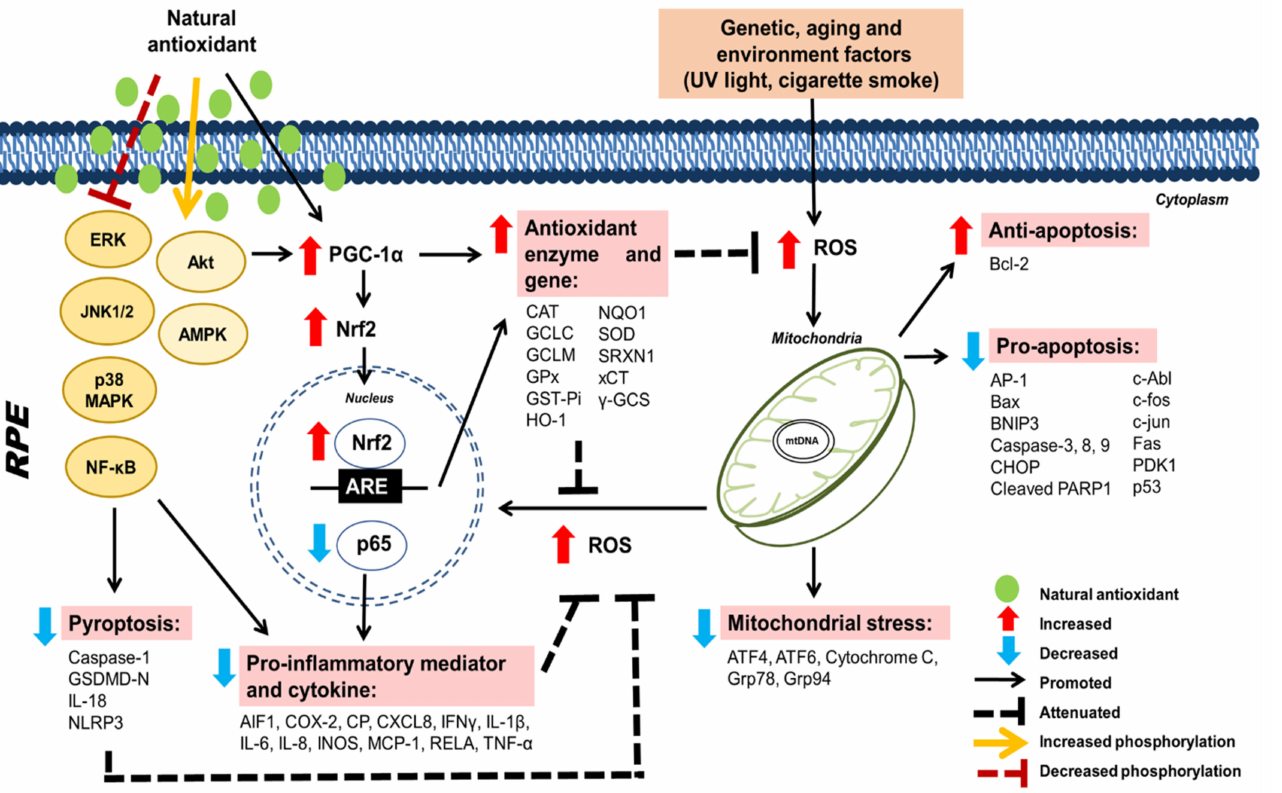
Figure 3. Genetic, aging and environmental factors exaggerate dysfunction and degeneration of reti- nal pigment epithelium (RPE) in age-related macular degeneration (AMD). Excessive production of reactive oxygen species (ROS) leads to mitochondrial dysfunction and mitochondrial DNA (mtDNA) damage, and therefore causing extracellular accumulation of insoluble protein aggregates. Modulation of extracellular-signal-regulated kinase (ERK), c-Jun N-terminal kinase (JNK)1/2, p38 mitogen-activated protein kinase (MAPK), nuclear factor kappa-light-chain-enhancer of activated B cells (NF- κ B), protein kinase B (Akt) and adenosine monophosphate-activated protein kinase (AMPK) activities by natural antioxidants results in decreased pyroptosis, inflammation, mitochondrial stress and apoptotic activity. Upregulation of peroxisome proliferator-activated receptor gamma coactivator 1-alpha (PGC-1 α ) and nuclear factor erythroid 2-related factor 2 (Nrf2) promotes the expression of antioxidant genes and enhances the capacity of antioxidant defense systems in attenuating the damaging effects of ROS